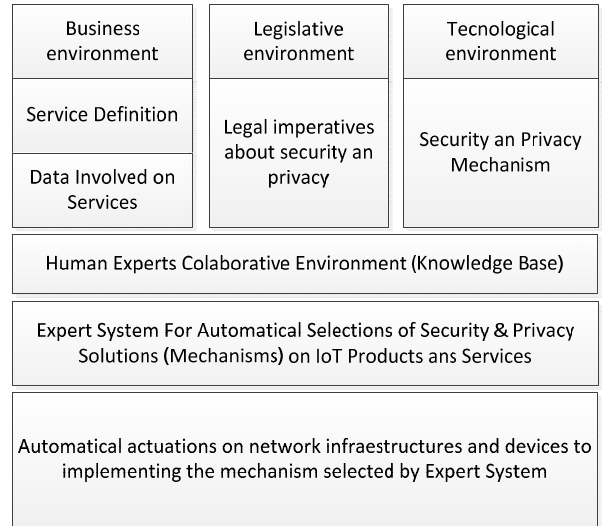
Figure 7. Involved information. Automatic Selection System for making decisions concerning security and privacy policies.